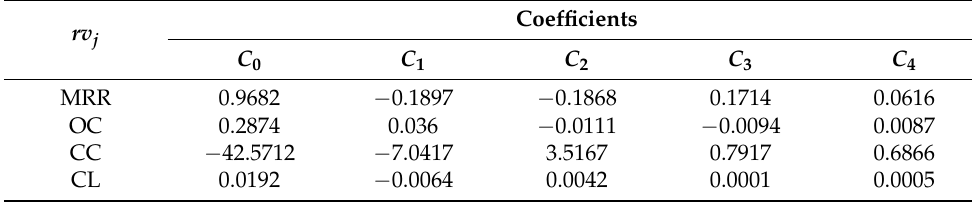
Table 5. Coefficients of linear regression equations—quenched.